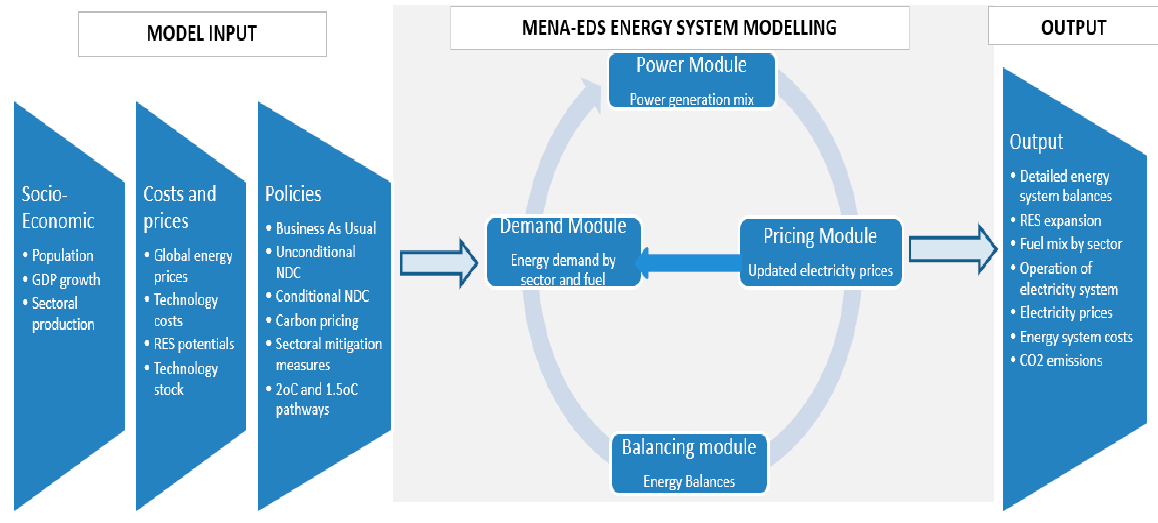
Figure 2. Schematic flow of the study design.